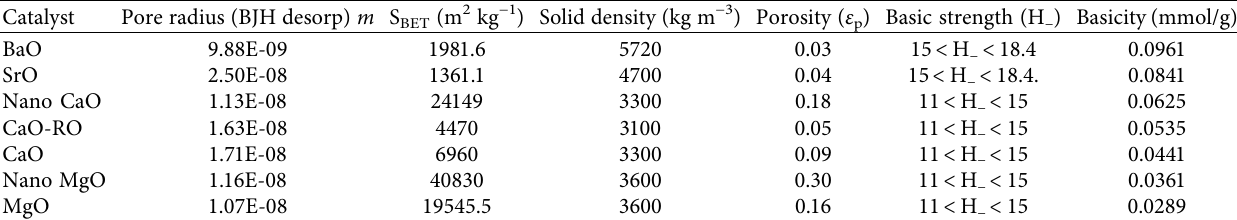
� BET surface area) [5]. BET